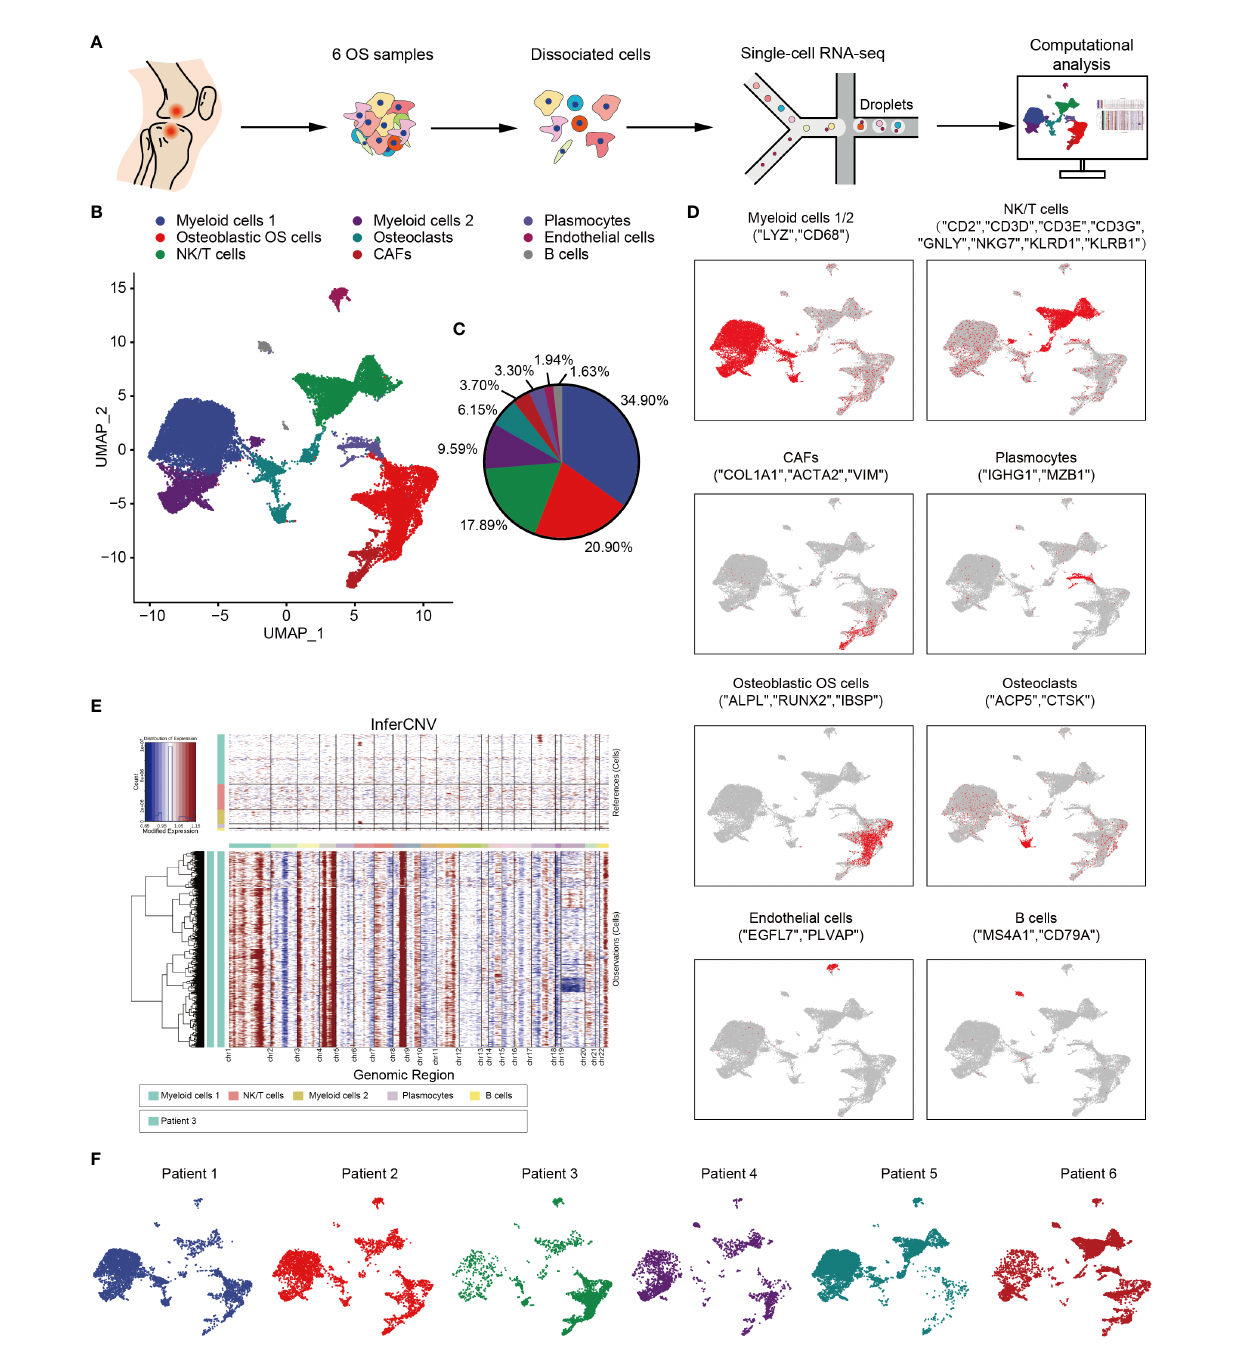
FIGURE 1 | Overview of single cells derived from OS tissues. (A) Work fl ow depicting collection and processing of specimens of OS tumors for scRNA-seq. (B) UMAP plot of all the single cells, with each color-coded for the 9 major cell types. (C) Pie chart, indicating the cell composition of OS. (D) UMAP plots of the normalized marker expression of the 9 major cell types. (E) The large-scale chromosomal landscape in patient 3 was calculated using reference cells (myeloid cells 1/2, NK/T cells, plasmocytes and B cells); the red color represents an increased copy number, whereas the blue color represents a decreased copy number. (F) UMAP plot of all the single cells, with each cell color-coded for different patients. OS, osteosarcoma; UMAP, uniform manifold approximation and projection; scRNA-seq, single-cell RNA sequencing; NK, natural